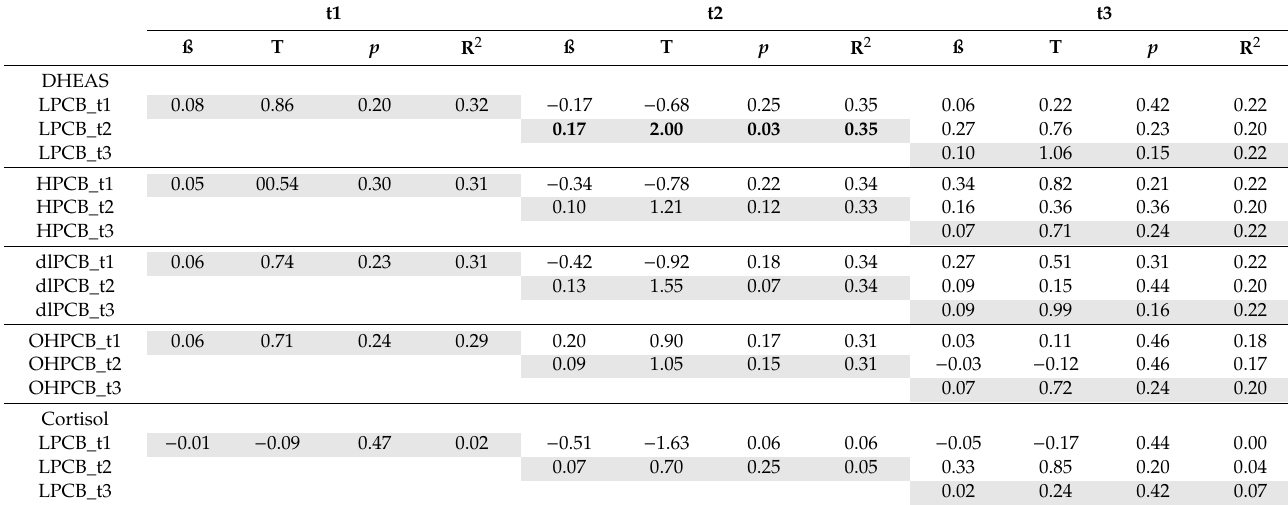
Table 6. Cross-sectional associations and associations over time between PCBs and DHEAS and cortisol from multiple linear regressions analyses ( N =